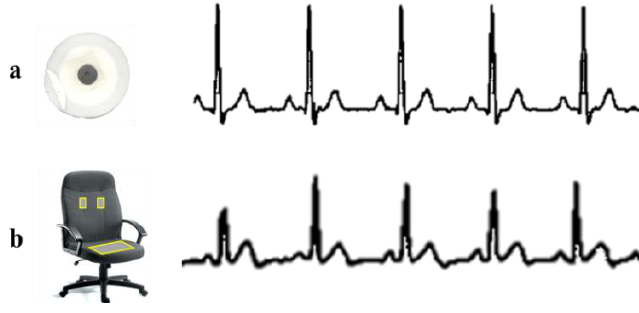
Figure 12. ( a ) ECG signals measured with standard ECG measurement; ( b ) ECG signal obtained using non-contact ECG measurement.